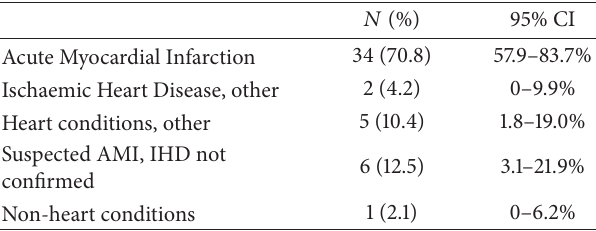
Table 5: Final diagnoses of the patients with prehospital diagnoses of Acute Myocardial Infarction ( 𝑛 = 48